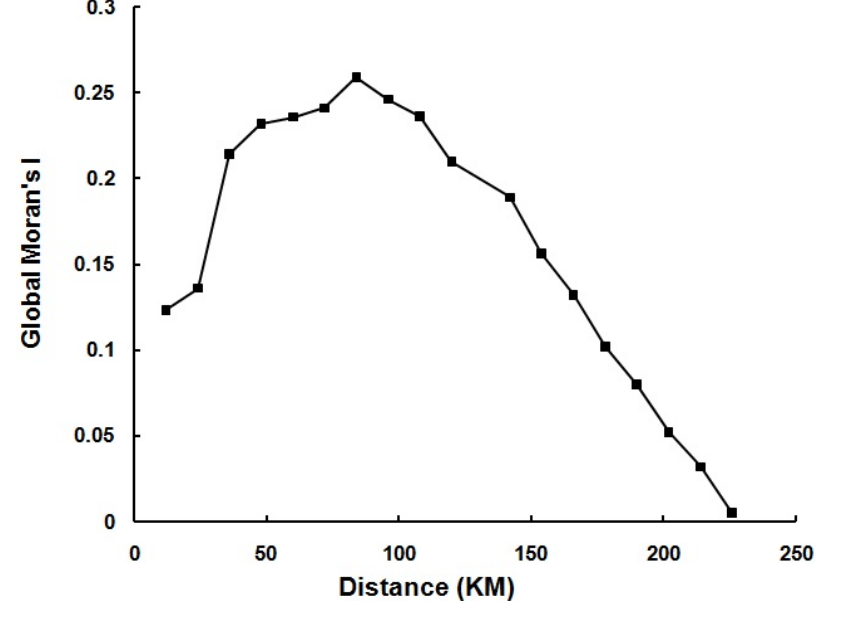
Figure 5. Spatial correlogram of FBC.